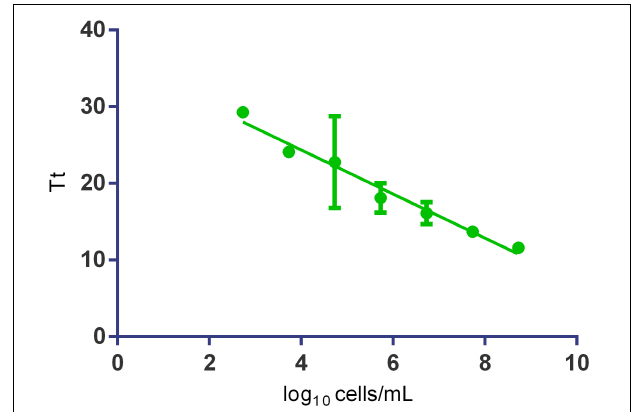
FIGURE 5 | The standard curves obtained by SYTO-9 fluorescence-based Cells-qLAMP from the 10-fold serial dilutions of O. oeni in the culture medium. The Tt values are the averages of three replicates. Error bars represent standard errors.